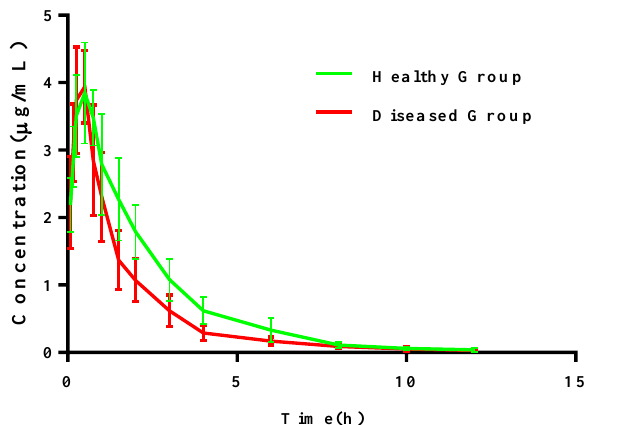
Figure 5. Concentration-time of cefquinome in plasma by 2 mg/kg b.w. intramuscular injection.